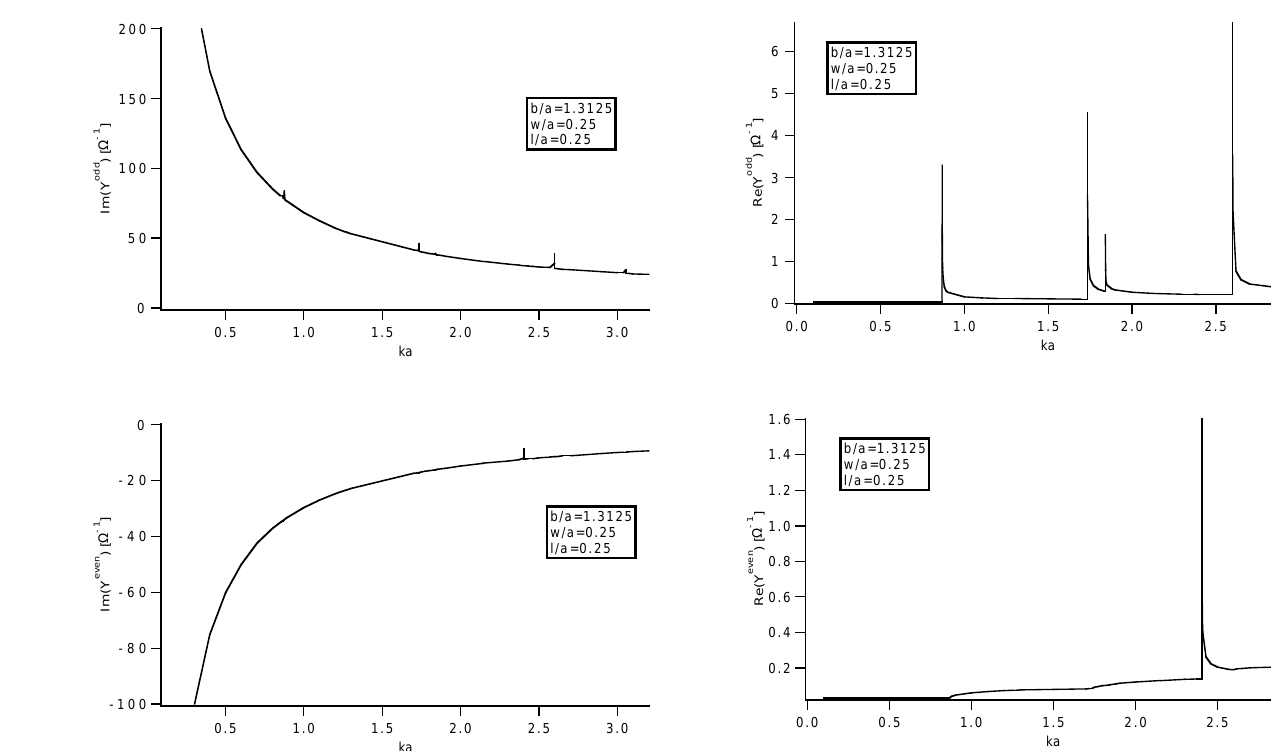
FIG. 3. Imaginary part of the admittance near the cutoff frequencies.